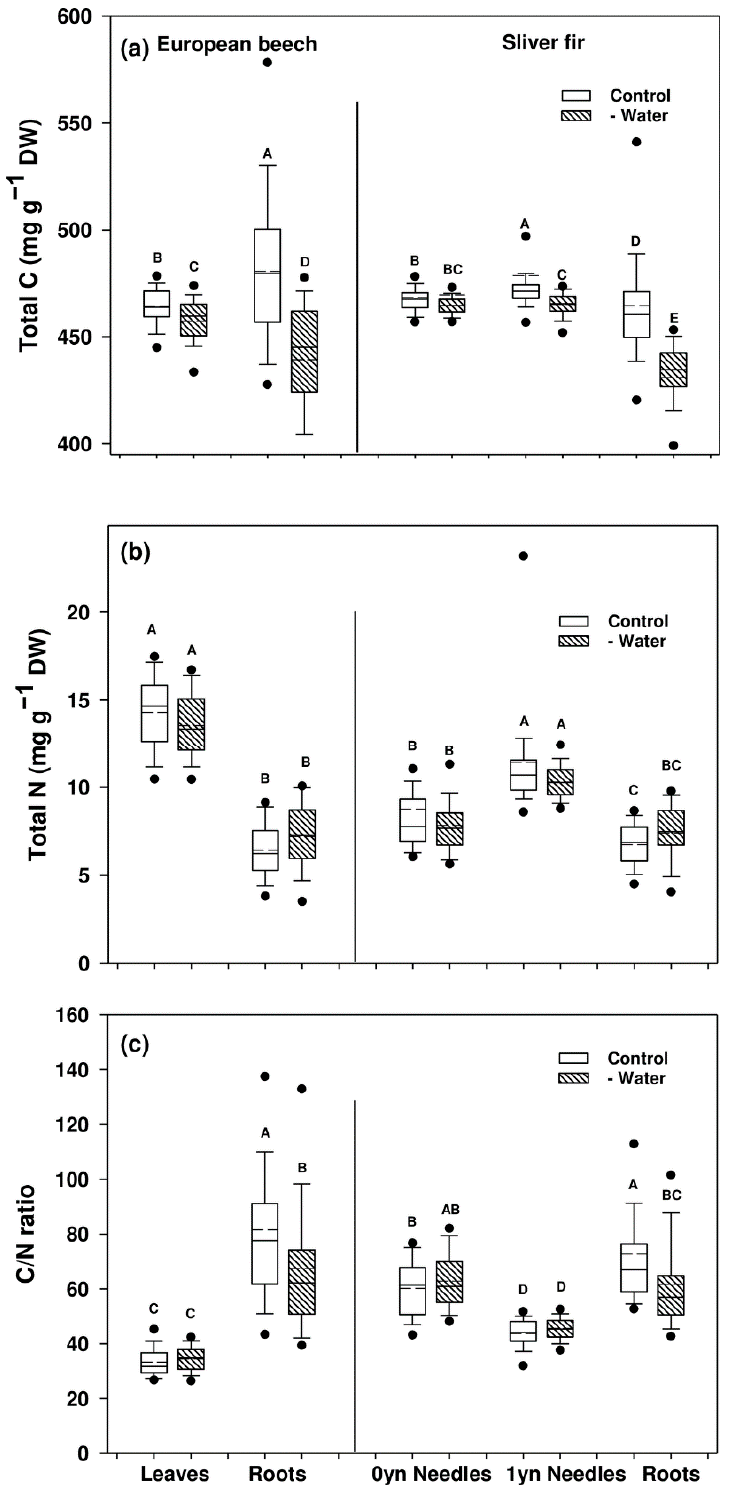
Figure 3. Total carbon ( a ), nitrogen ( b ), contents and carbon (C)/nitrogen (N) ratio ( c ) of European beech and silver fir seedling after two years of growth in mixed cultivation regardless of the number of inter-species neighbors. -Water: Beech/fir mixtures exposed water deprivation and rewatering during the first year of growth. Data shown are means ± SD (beech: n = 75–80: fir n = 74–80). Significant differences ( p < 0.05) are indicated by different capital letters.